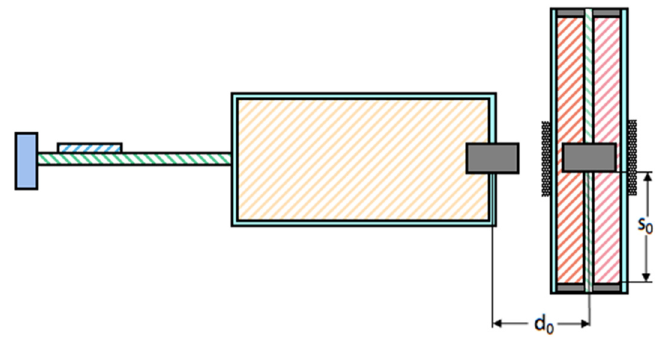
Figure 3. The MPEGEH cross